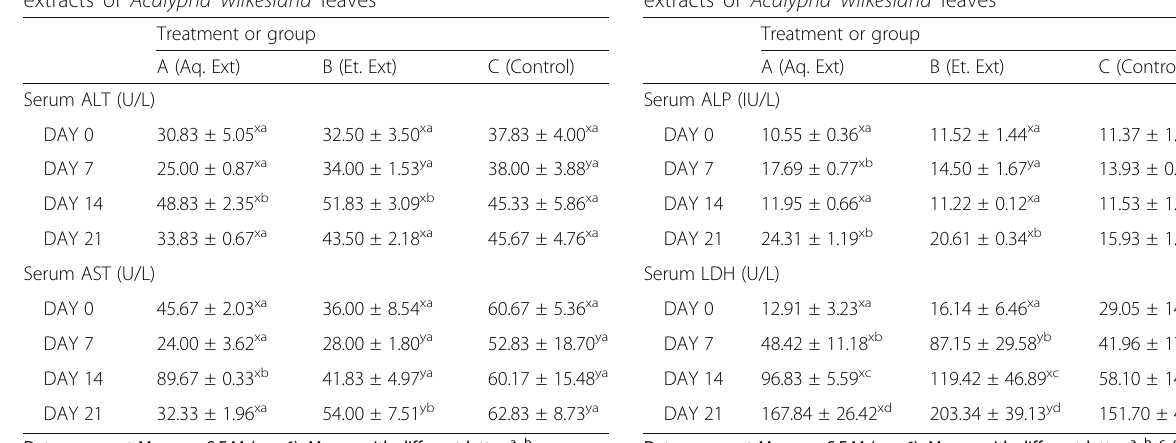
Data represent Means ± S.E.M ( n = 6). Means with different letter a, b, c, d superscripts, along column, are significantly different ( p < 0.05). Means with different letter x, y superscripts, along row, are significantly different ( p <